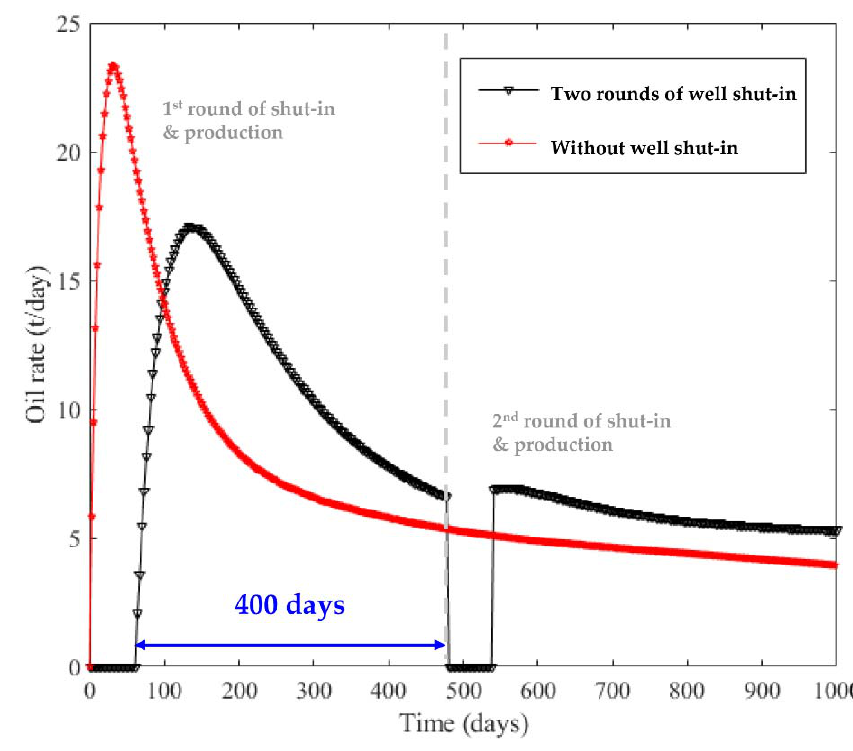
Figure 18. Daily oil rate with 400 days of first round of production.